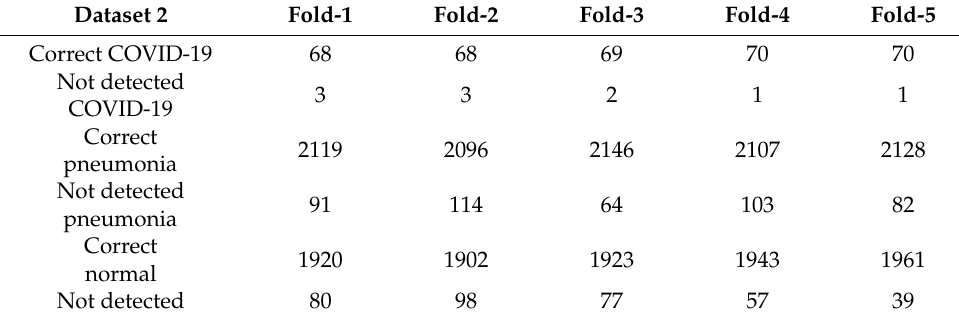
Table 10. Detailed dataset 2